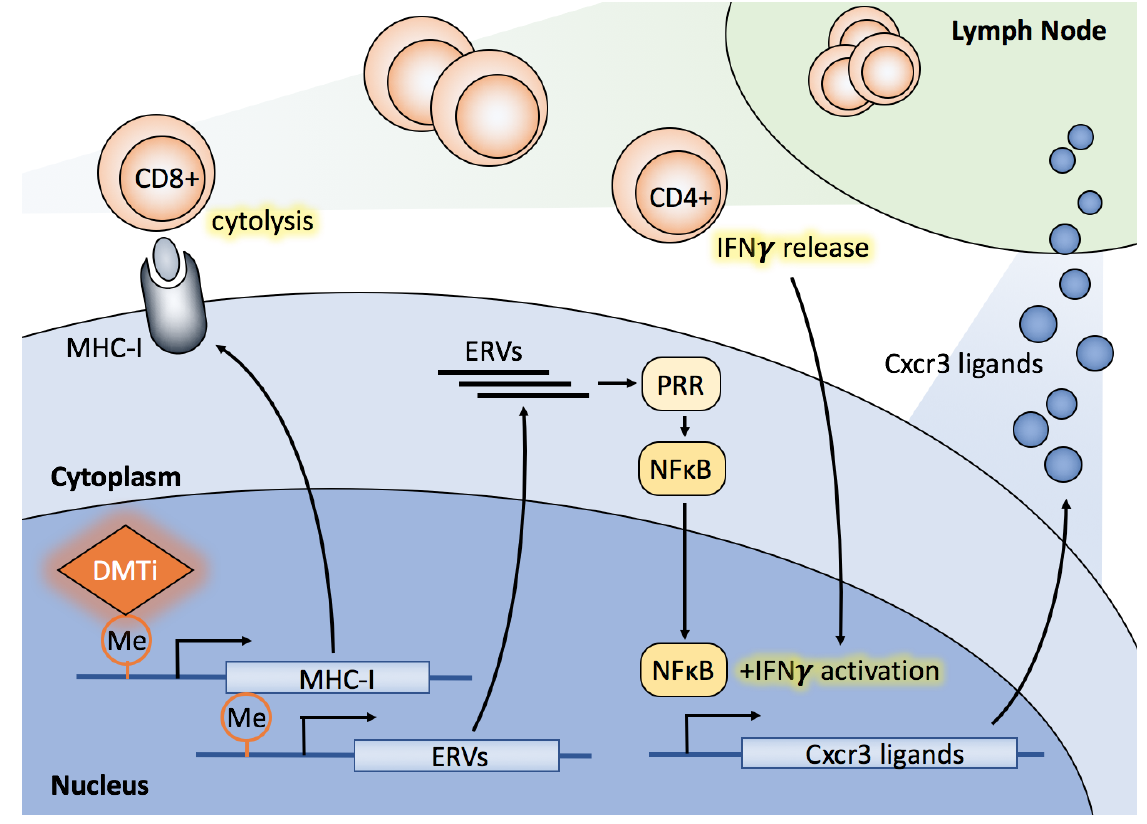
FIGURE 1: Multiple mechanisms of DMTi potentiation of anti-tumor immunity. First, DMTi treatment up-regulates baseline MHC-I ex- pression and MHC-I expression in response to IFN-γ, thereby enhancing antigen presentation capacity and cytotoxic CD8 + T cell activation. Second, DMTi treatment increases Cxcr3 chemokine (i.e., Cxcl9, Cxcl10, Cxcl11 ) expression, thereby enhancing T cell trafficking to the tu- mor microenvironment. Third, DMTi treatment activates NFκB signaling, presumably through ERV dsRNA expression, initiating an innate immune response. Each of these mechanisms in toto likely contribute to enhanced response to ICI